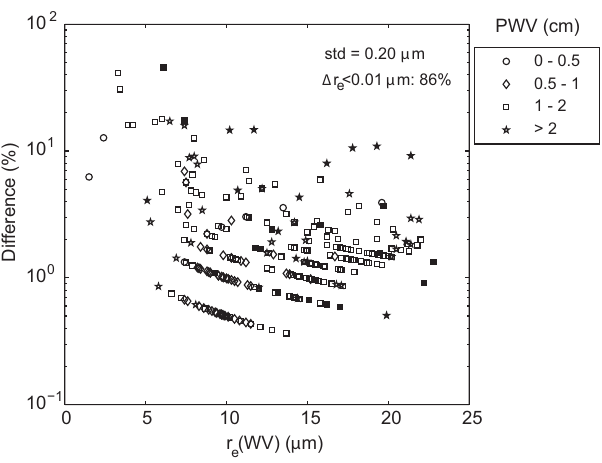
Fig. A1. Percent difference in retrievals of r e associated with not subtracting water vapor contributions to measured downwelling ra- diance in emissivity calculations (Eq. 6), versus retrieved values with water vapor subtracted, as a function of the precipitable water vapor content (PWV) of the atmosphere. The only differences plot- ted are those in the 14% of cases with differences in r e > 0 . 01µm. Negative differences are in closed